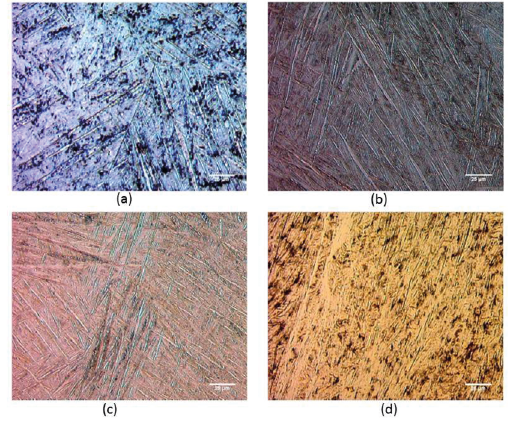
Figure 1. Optical micrograph of the Ti-30Ta alloy (a) without deformation (b) 19% of deformation (c) 22% of deformation (d) 43% of